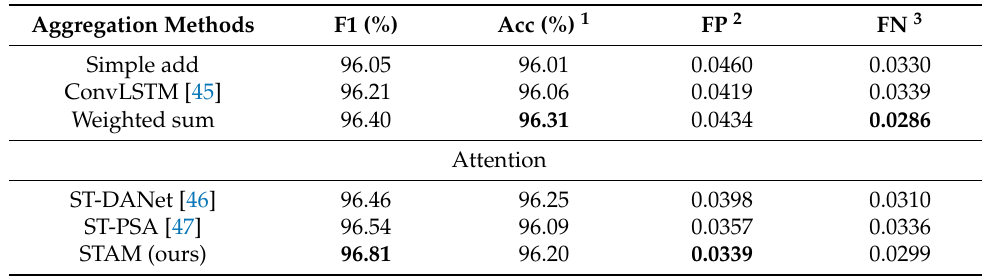
Table 4. Experimental results with different aggregation strategies. The number of frames is 4 and multi-frame pre-alignment is used.